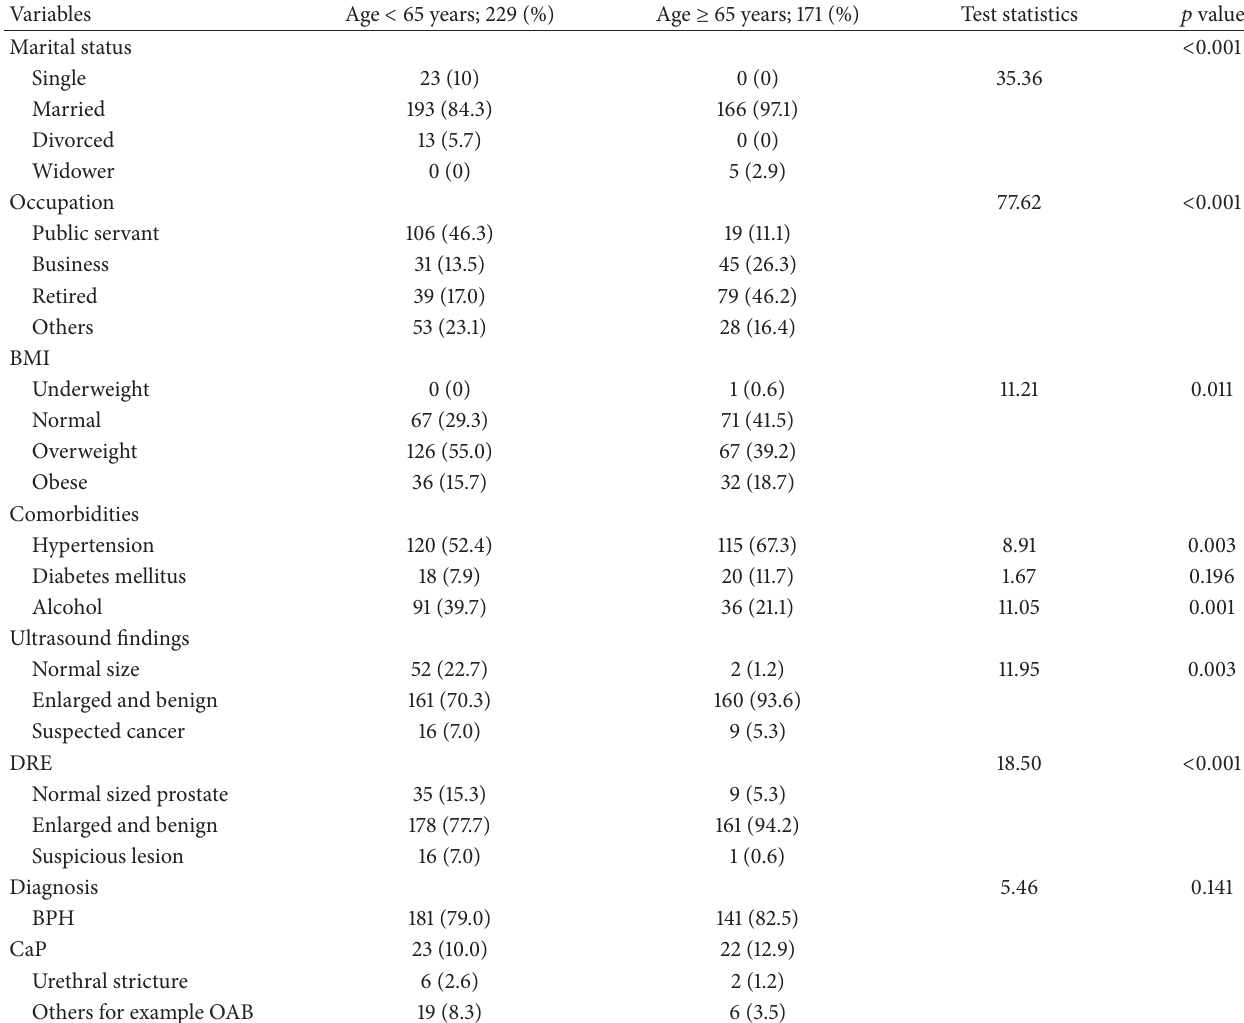
Table 1: Demographic characteristics of the study population.